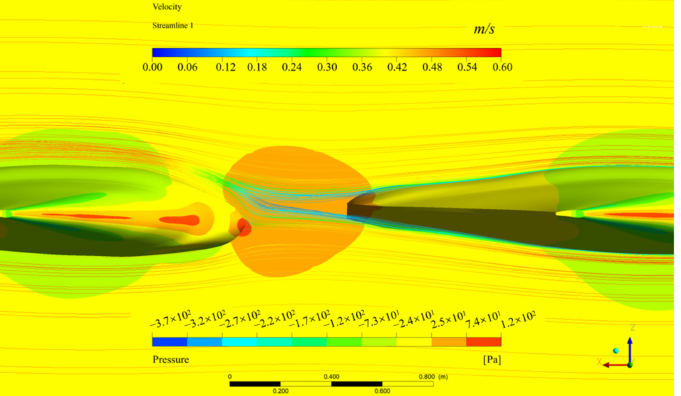
Figure 13. Surface pressure distribution and streamline diagram of the symmetry plane of two manta rays tandem system at α = − 2 ◦ , ∆ s = 0.25